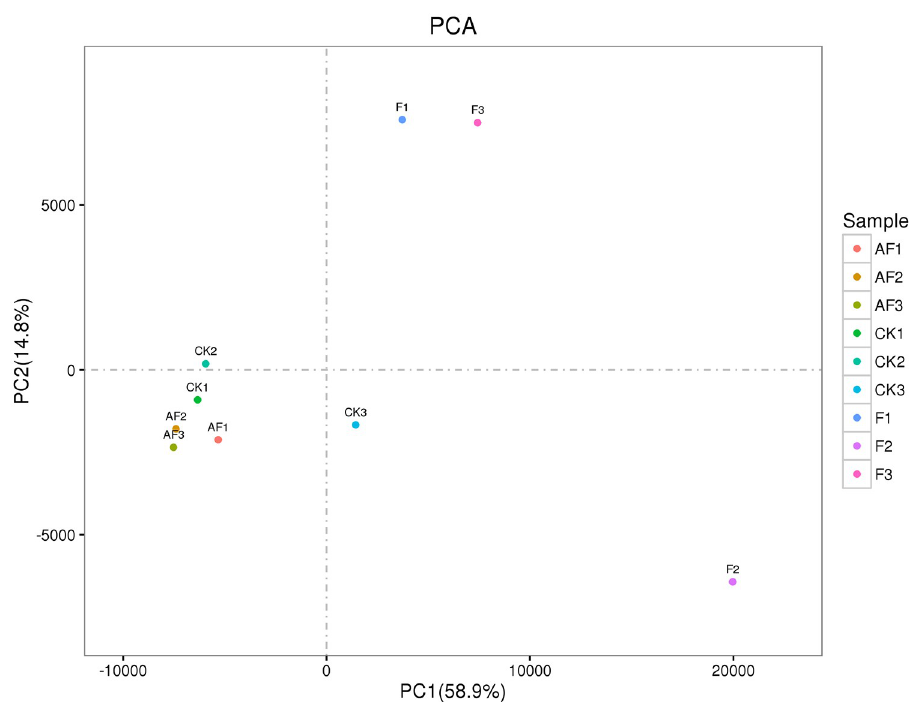
Fig 5. PCA. According to the value of each sample in the first principal component (PC1) and the second principal component (PC2), two-dimensional coordinate map is made. The values in brackets on the axis labels represent the percentage of the variance of the population explained by the principal component. PC1 can explain 55% of the total variance of all variables (expression of all genes), PC1 and PC2 can explain 91.7% of the total variance.